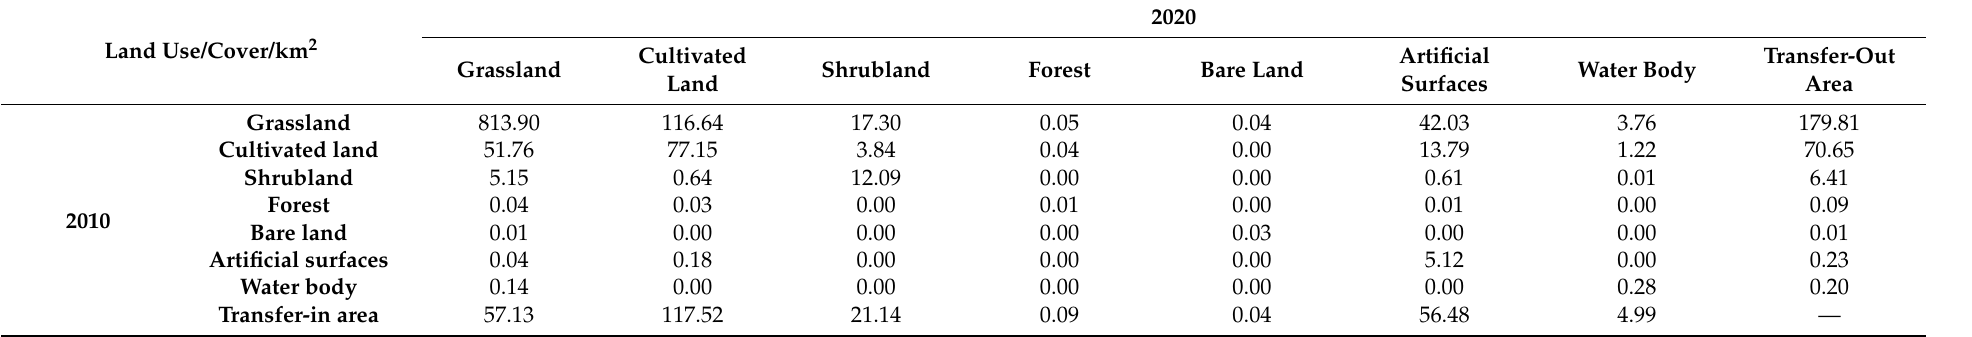
Table 3. Land use/cover conversion matrix of alluvial fans from 2010 to 2020.